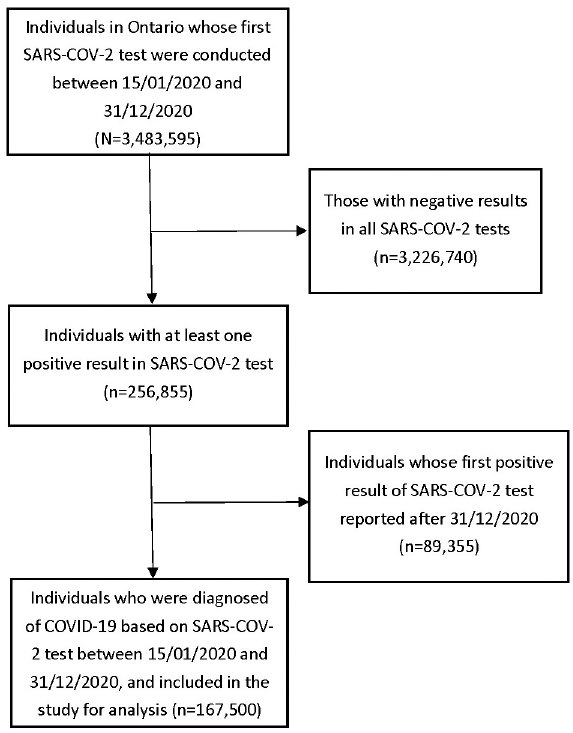
Fig 1. Flowchart of 167,500 individuals included in this